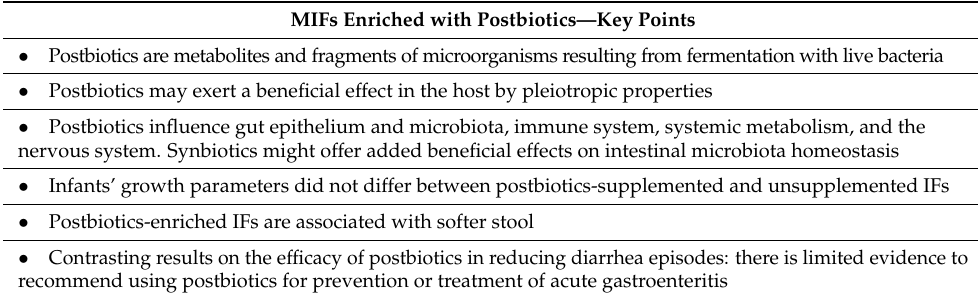
Table 6. Summary of beneficial effect of MIFs enriched with